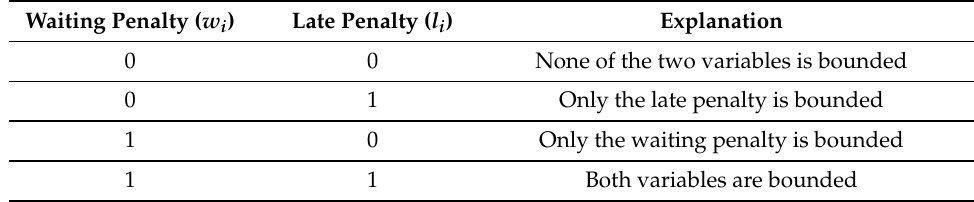
Table 1. Data collection